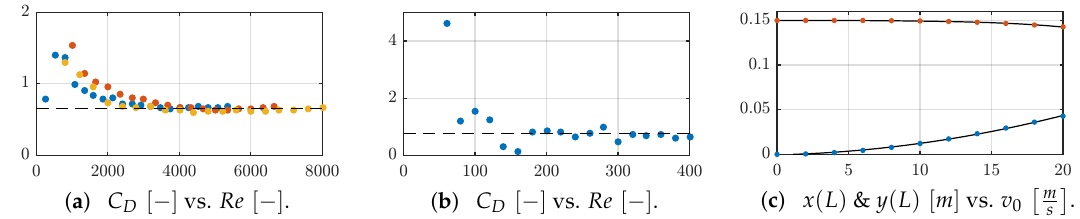
Figure 5. Drag coefficient c D for: ( a ) D4 (blue), D5 (red), D6 (yellow) and ( b ) D03 in dependence on the Reynolds numbers according to v 0 = ˜ v m , ˜ v ∈ [ 0,20 ] . The dashed line in ( a ) corresponds to a s value of 0.65 and the one in ( b ) to 0.75. ( c ) shows the tip position with x ( L ) (blue) and y ( L ) (red) and corresponding curve fits (black solid line) of D03 for v 0 = ˜ v m , ˜ v ∈ [ 0,20 ] . s